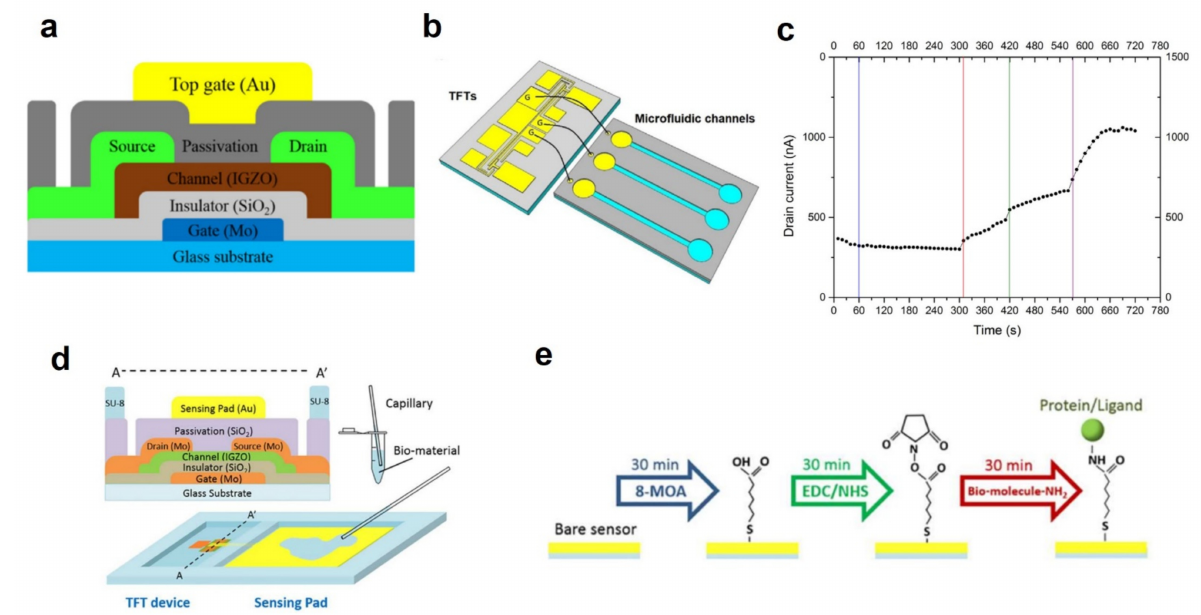
Figure 9. ( a ) Structure of the IGZO biosensor; ( b ) The biosensor integrated with TFTs for electrical signal readout and microfluidic channels for fluidic property monitoring. The circular pools near the TFT were coated with an Au metal plate; ( c ) Transient current response of the solution mixed with biotin and streptavidin (adapted from [118] with permission from Elsevier B.V.); ( d ) Structure of the IGZO TFT biosensor; ( e ) Production process of the IGZO TFT biosensor (adapted from [119] with permission from PLoS